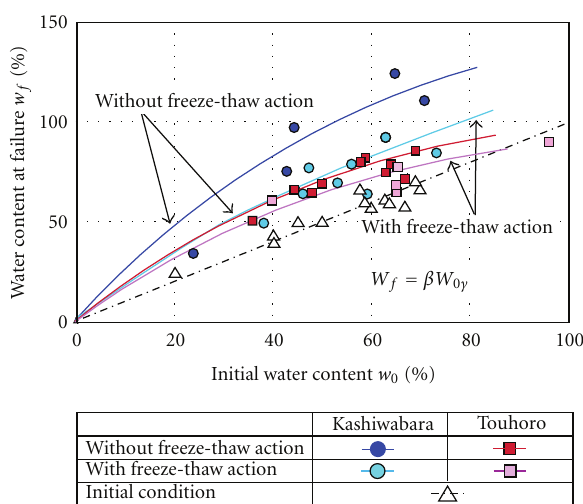
Figure 17: Relationship between water contents at initial w 0 and at failure w f for typical volcanic soils (Kawamura et al. [17]).